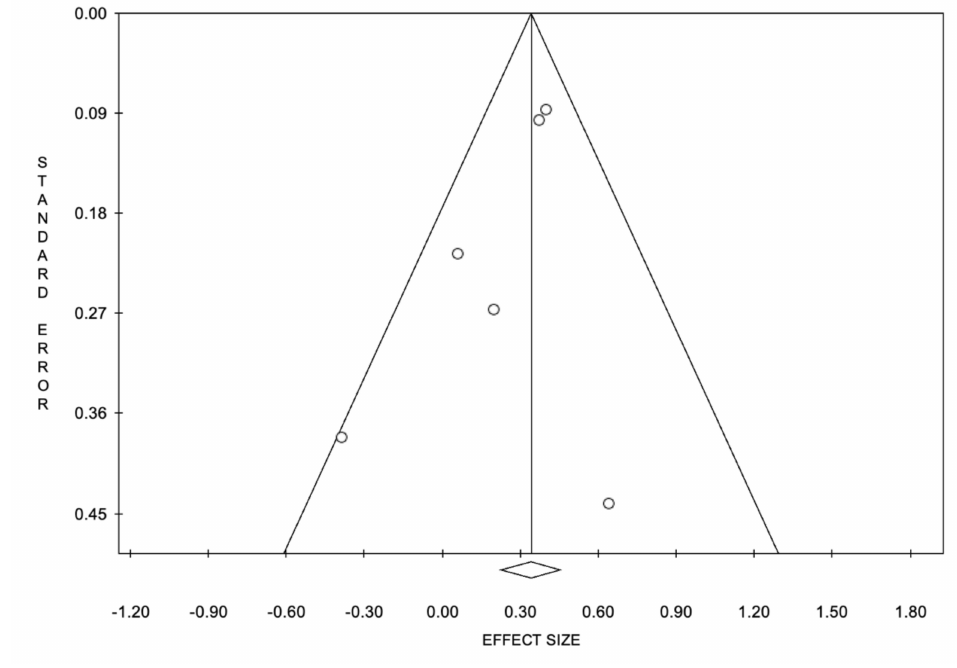
Figure 4. Funnel plot of overall survival.